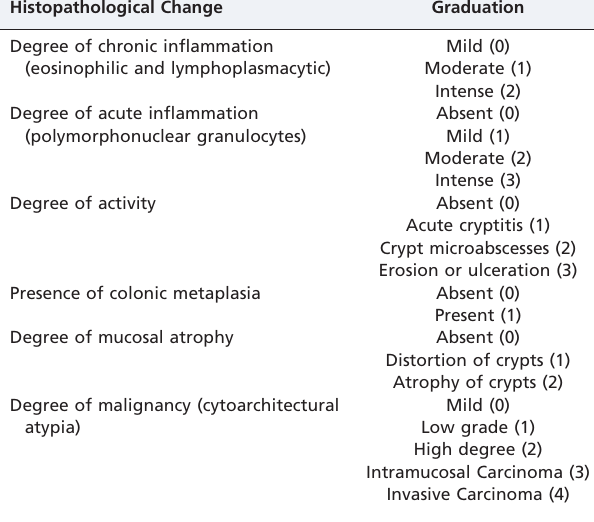
Table 1 - Graduation and criteria adopted for the histopathological characterization of ileal